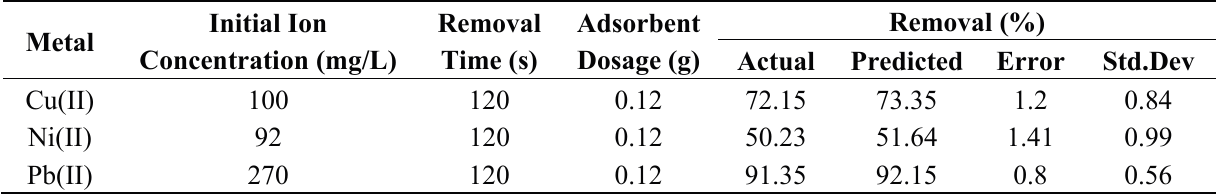
Table 4. Optimized conditions for Cu(II), Ni(II) and Pb(II) removal. Std.Dev, the square root of the